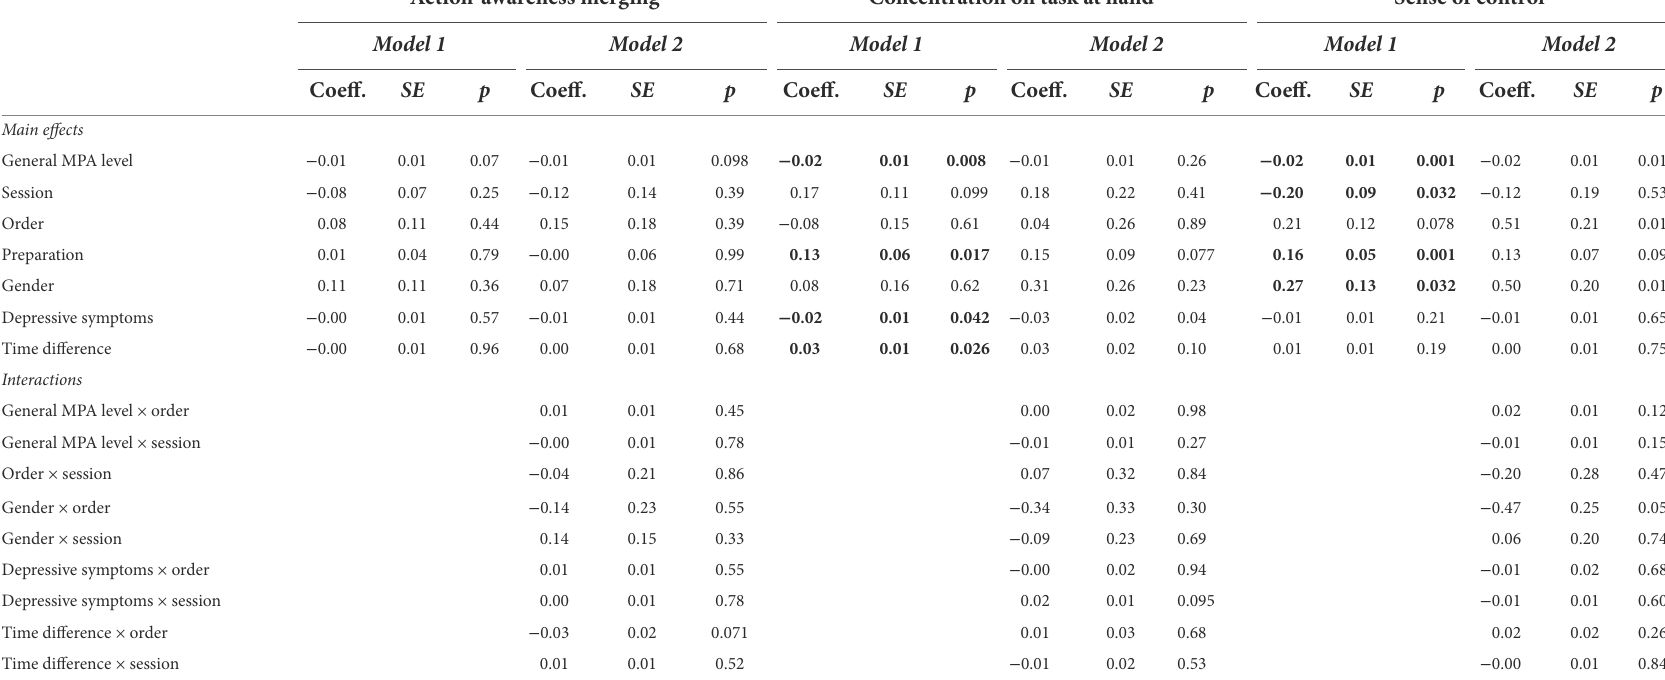
TABLE 4 Estimated linear mixed models for the dimensions “action-awareness merging,” “concentration on task at hand,” and “sense of control.” Action-awareness